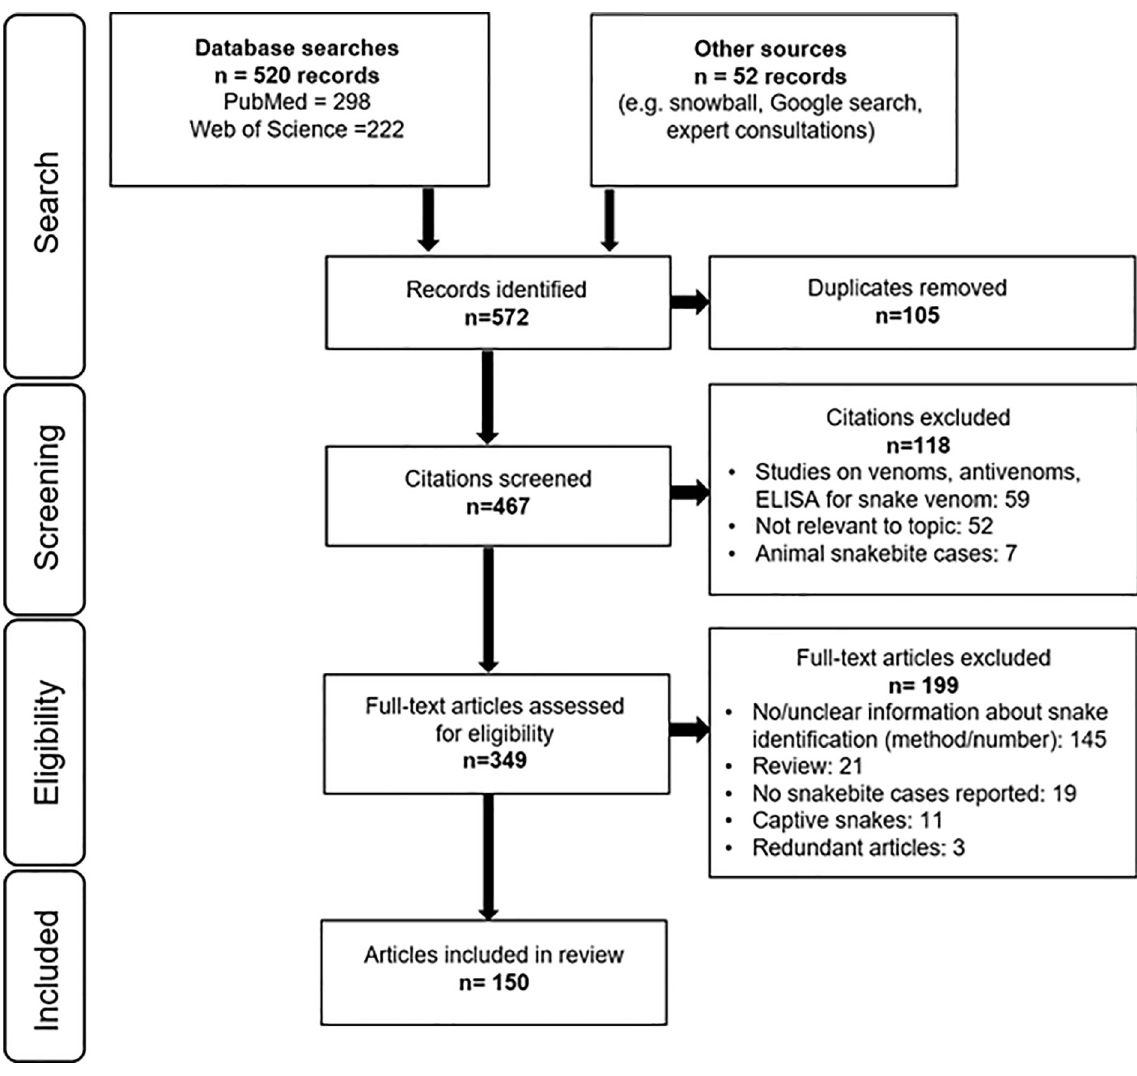
Fig 1. PRISMA flow